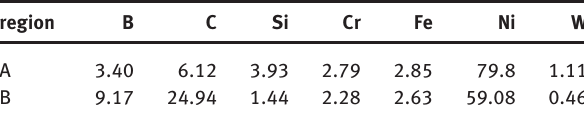
Table 1: Chemical composition characteristics of region Ι (wt.%).